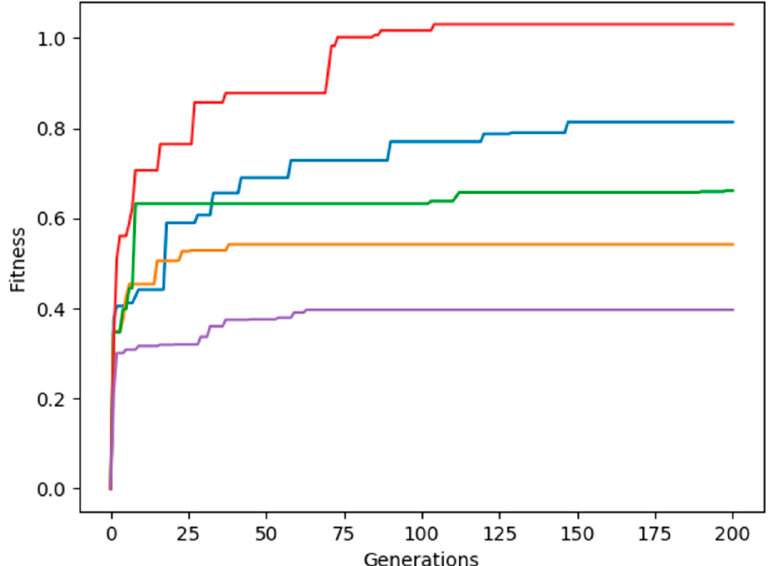
Figure 9. Random joint movement or joint asymmetry for 5 different simulation runs.